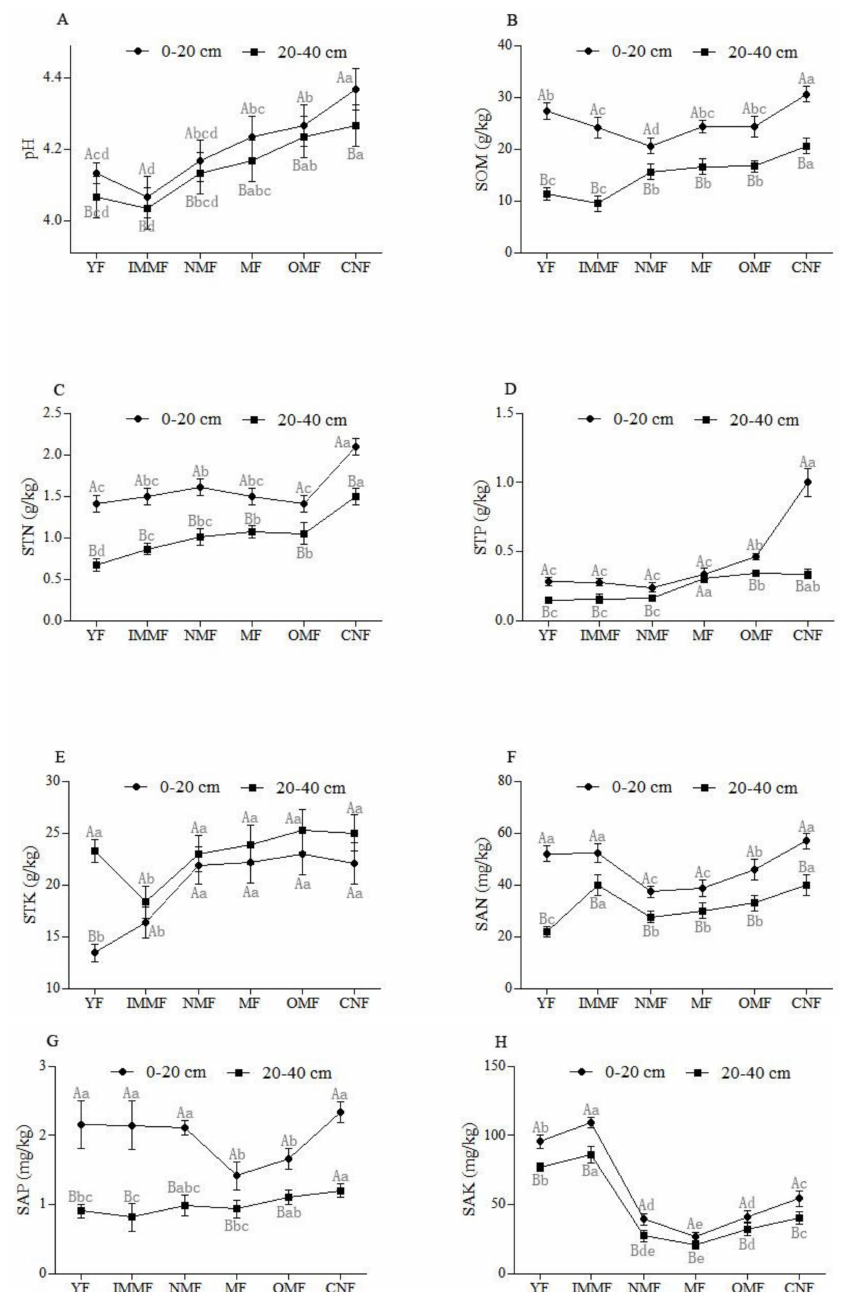
Figure 1. Soil chemical characteristics. General soil properties at the Experimental Center of Sub- tropical Forest, China. Properties are average values measured for soil samples (the experiment was repeated three times for each sample) taken from each replicate plot in 2018 ( n = 9). p -values within each column were determined by ANOVA. Different lowercase letters and different uppercase letters represent significant differences between the same soil depth of different stand ages and between different soil depths (0–20 cm and 20–40 cm) of the same stand age ( p < 0.05), respectively, as determined by Tukey’s HSD test ( α = 0.05). The same below. ( A ) pH values, ( B ) soil organic matter (SOM) concentrations, ( C ) soil total nitrogen (STN) concentrations, ( D ) soil total phosphorus (STP) concentrations, ( E ) soil total potassium (STK) concentrations, ( F ) soil alkali-hydrolyzable nitrogen (SAN) concentrations, ( G ) soil available phosphorus (AP) concentrations, ( H ) soil available potassium (SAK) concentrations in different stand ages and different soil